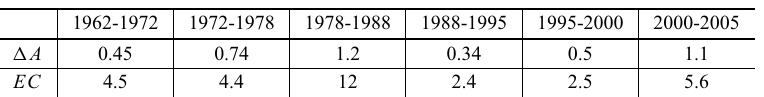
Mean rates of the areas occupied by cerradão expansion in the Corumbataí reservation over the different periods (1 A ) ; hectares occupied by cerradão expansion over the different periods ( EC )